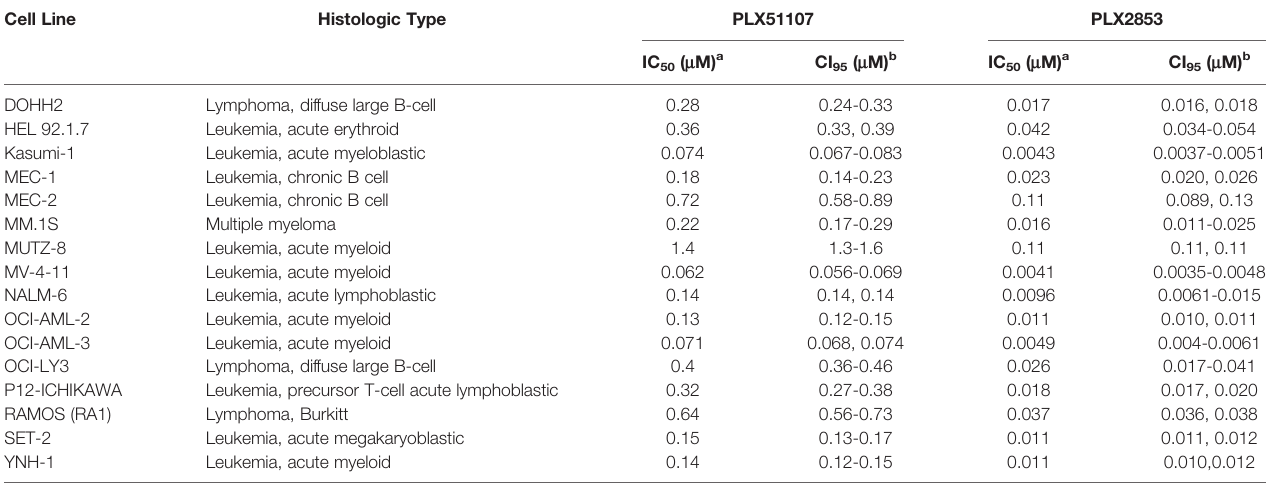
TABLE 2 | IC 50 values for the growth inhibition of hematologic malignant cells by PLX51107 and PLX2853. Cell